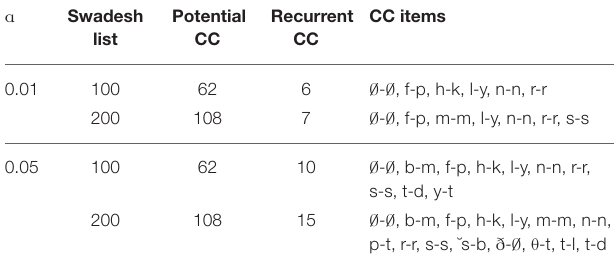
The first 100 concepts are from the Swadesh 100-word list. “ TABLE 3 | Potential and recurrent word-initial consonant correspondences (CC) in the assembled words from English (left) and Latin (right) following the Swadesh 100- and 200-word lists (extracted from Ringe,